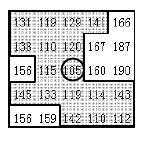
Figure 4. K-means clustering within a 5 × 5 neighbourhood Directional region growing